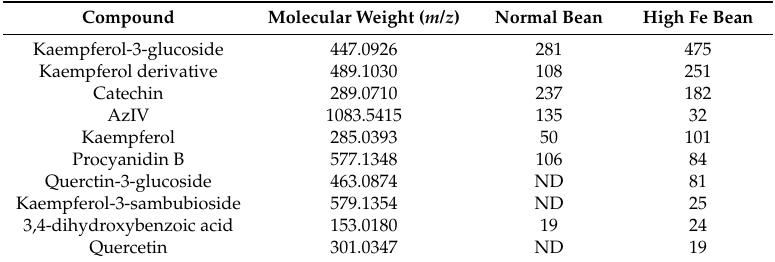
Table 3. Polyphenolic profile of the seed coat of the normal and high Fe beans 1 .